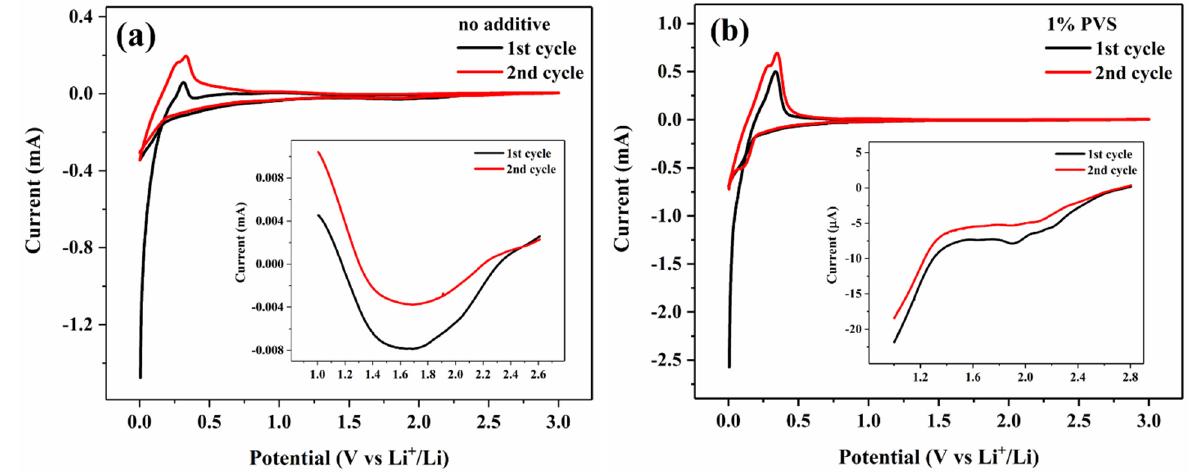
Figure 3. The CV curves of the Li/graphite half-cells in the ( a ) electrolyte without additive and ( b ) electrolyte containing 1 wt % of PVS.